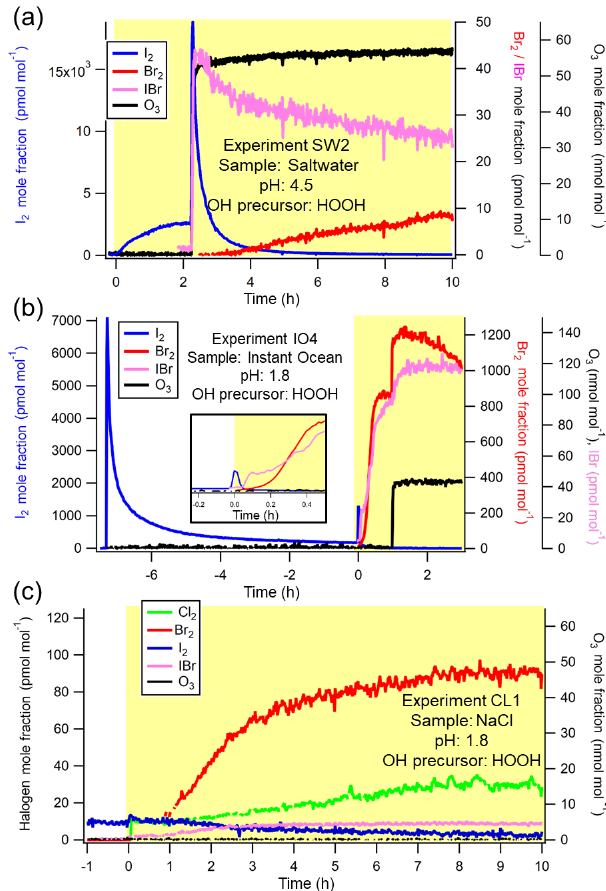
Figure 2. Representative experiments of OH-mediated production of X 2 and subsequent production of X 2 from O 3 addition. (a) Salt- water experiment (SW2) at pH = 4.5. (b) Instant Ocean experiment (IO4) at pH = 1.8. Time-varying Br 2 and IBr signals before t = 0 are shown in Fig. S2 in the Supplement. Inset more clearly shows the increase of I 2 signal after irradiation. (c) NaCl experiment (CL1) at pH = 1.8. Timescale represents hours from the activation of the lights, and the yellow shading represents presence of radiation from solar simulator bulbs. Gaps in data represent periods when the iso- topic ratios showed an